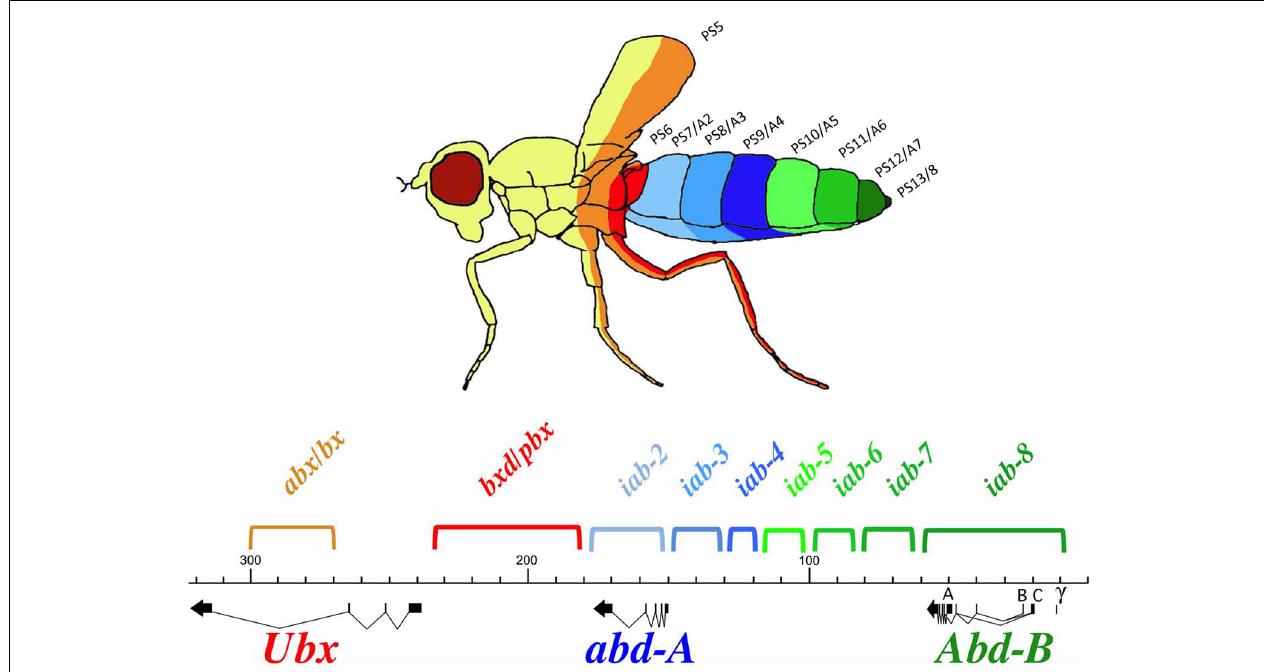
FIGURE 1 | Synopsis of the BX-C. The genomic region of the BX-C is marked off in kilobases according to the numbering of (Martin etal., 1995). The three transcription units Ubx , abd-A, and Abd-B with their exons marked as thick lines and the arrows showing the transcription polarity are drawn below the DNA map. The horizontal and colored brackets above the DNA line indicate the extends of the segment-specific cis- regulatory regions with the following color code. Orange and red ( abx/bx and bxd/pb ) regulate expression of Ubx in PS5/T3 and PS6/A1, respectively. The blue